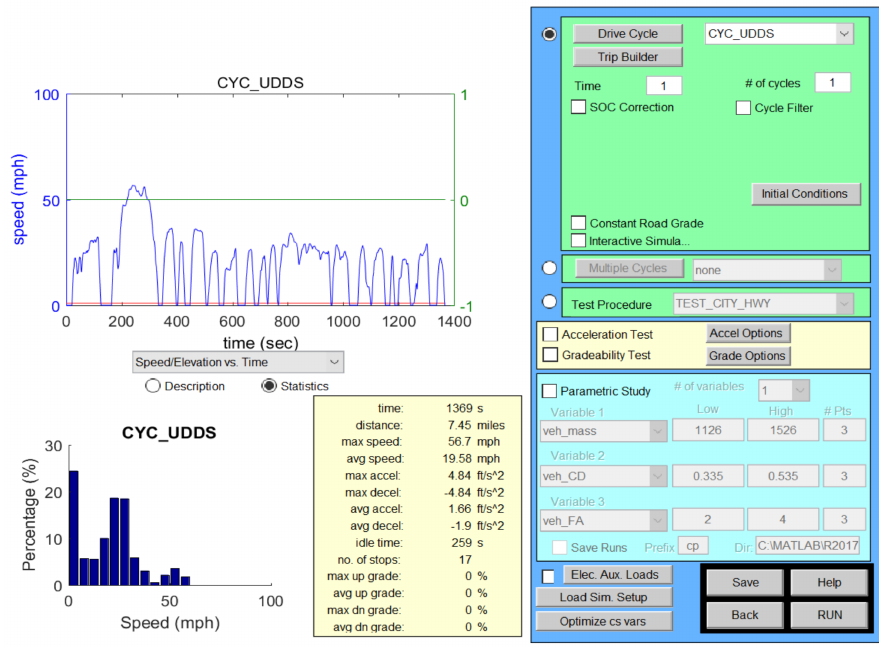
Figure 4. UDDS driving speed cycle of the input HEV SMcar.